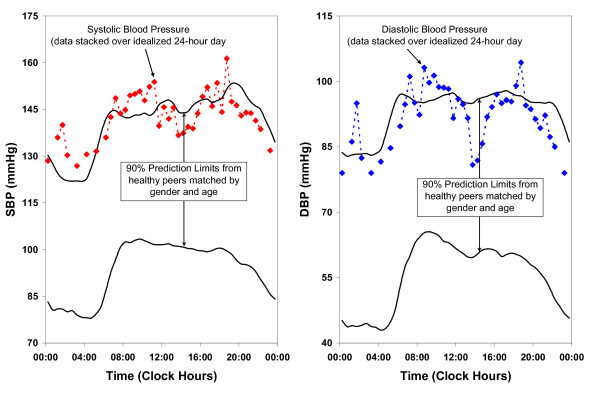
MESOR-hypertension.